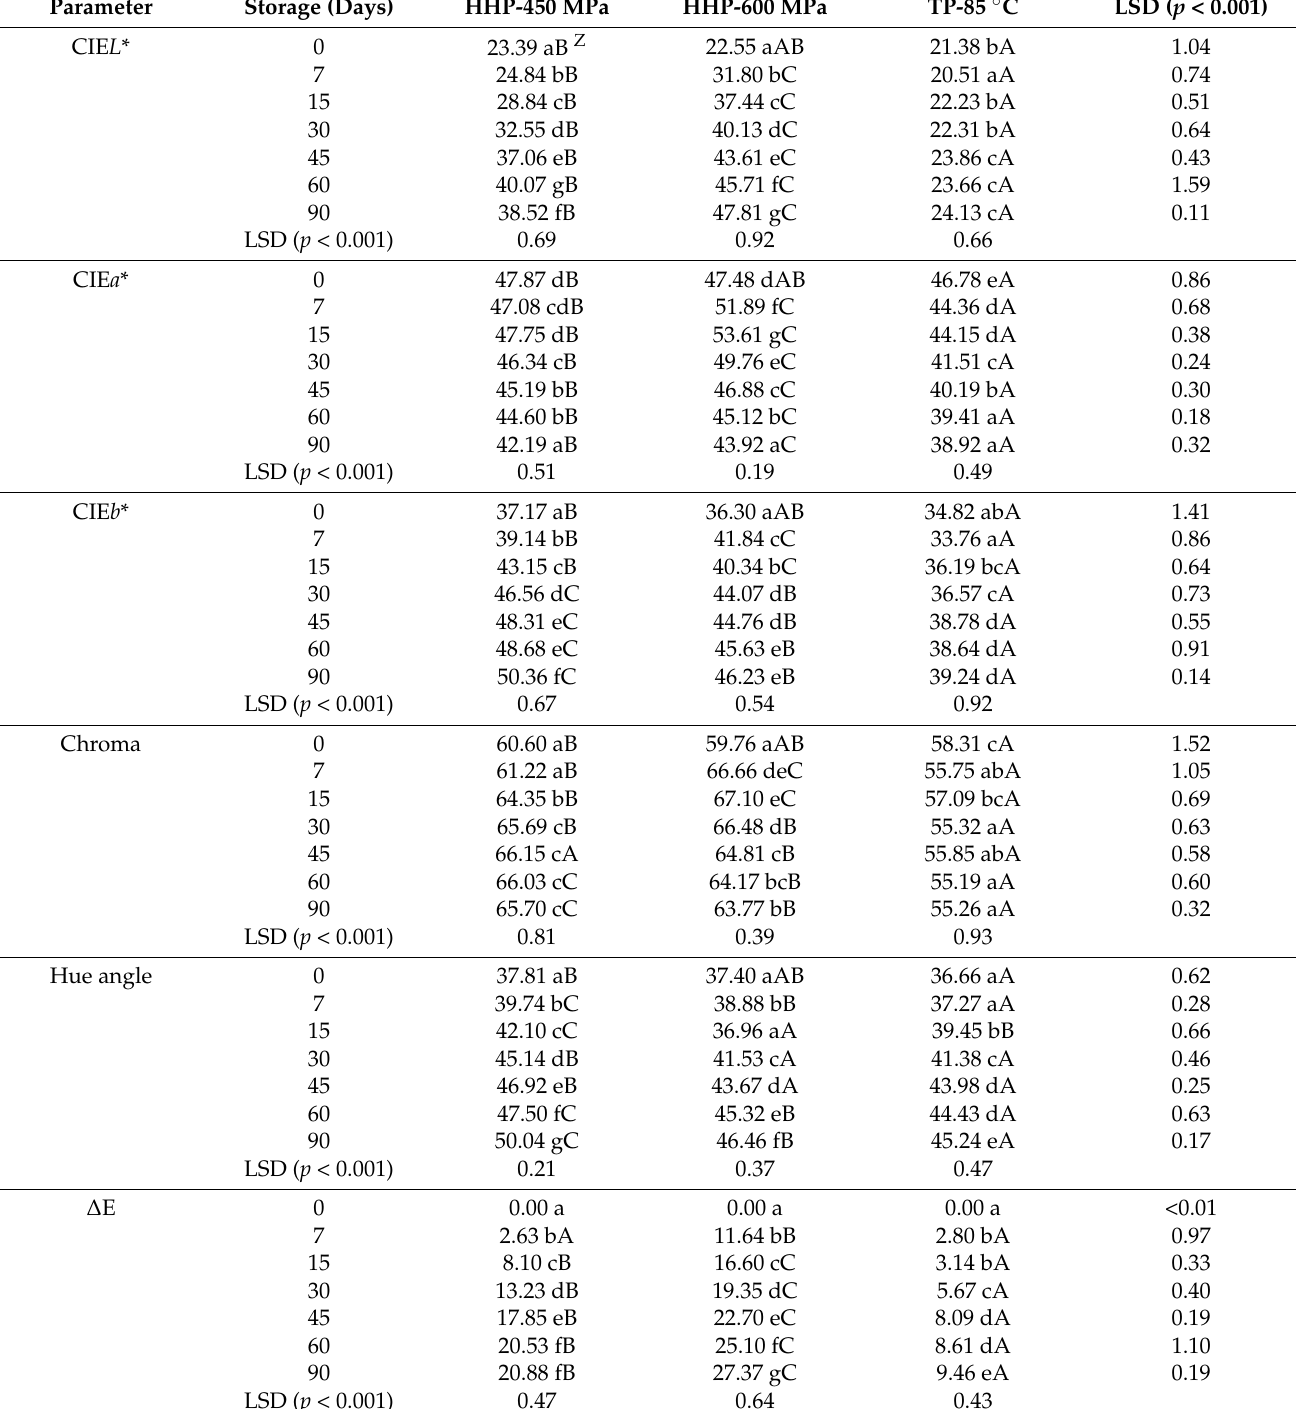
Table 6. Stability of CIE L * a * b * values in beverages stored at 20 ◦